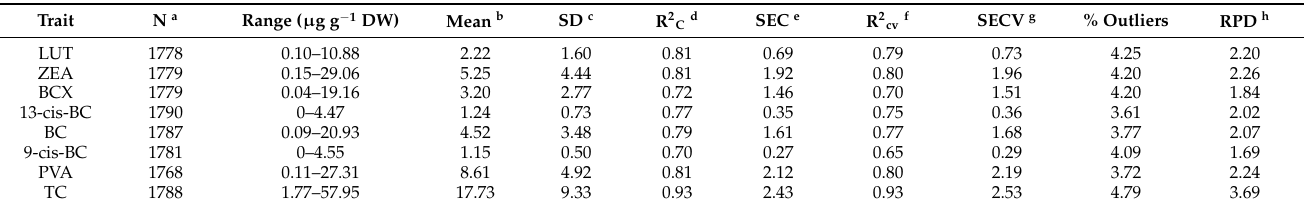
Table 3. Reference values for NIRS calibration, and cross-validation statistics in the calibration set of the maize lines.